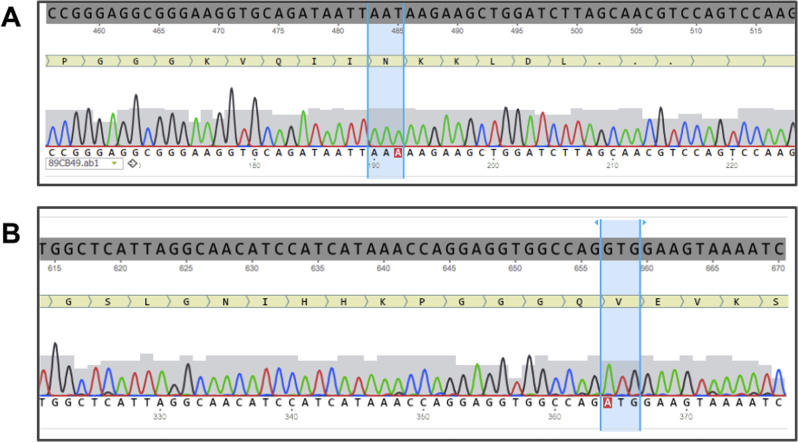
Sequence alignments confirming the creation of two FTPD-17 mutations in the K18 WT tau construct. (A) Sequence alignment showing the creation of the N279K point mutation (AAT (Asn) → AAA (Lys)). This pathogenic mutation is within the second tau repeat, present only in 4R isoforms. (B) Creation of the V337M mutation (GTG (Val) → ATG (Met)) in the third repeat region of tau. This mutation can affect both 3R and 4R tau isoforms due to its location in a constitutively-spliced region. Horizontal sequences shown in gray are those of the original construct (K18 WT). The corresponding amino acid sequence is shown in yellow underneath. Aligning nucleotide sequences from DNA sequencing are indicated under the chromatogram. Nucleotides highlighted in red indicate variation from the reference sequence. Sites of the mutations are highlighted in blue.